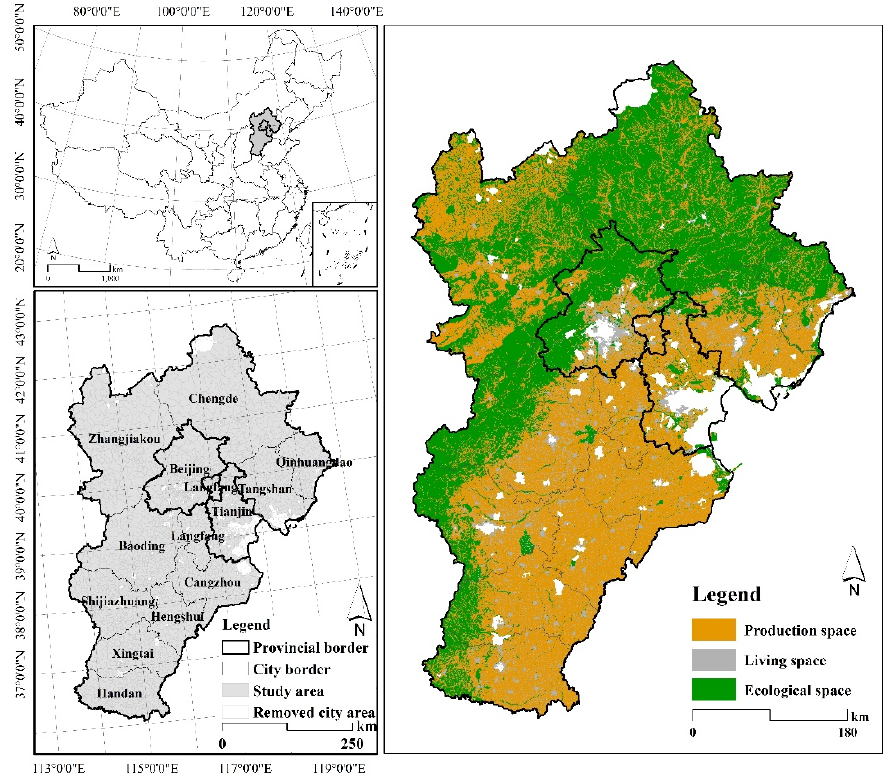
Figure 1. Research area of Beijing-Tianjin-Hebei region.